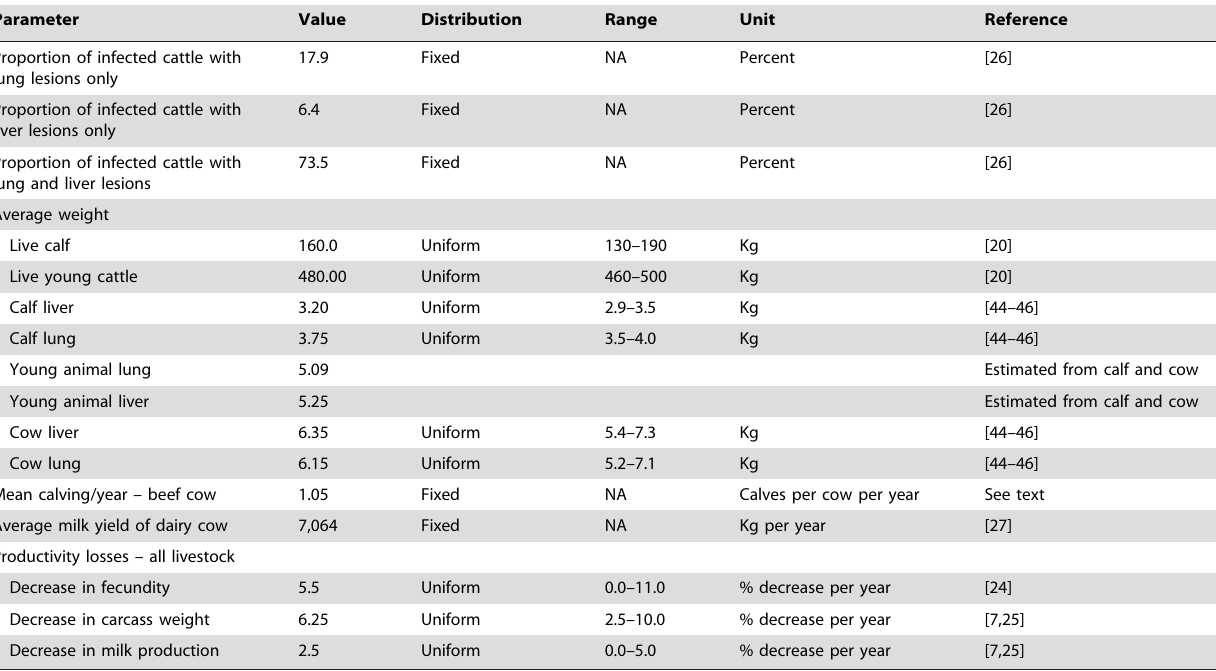
Parameter Value Distribution Range